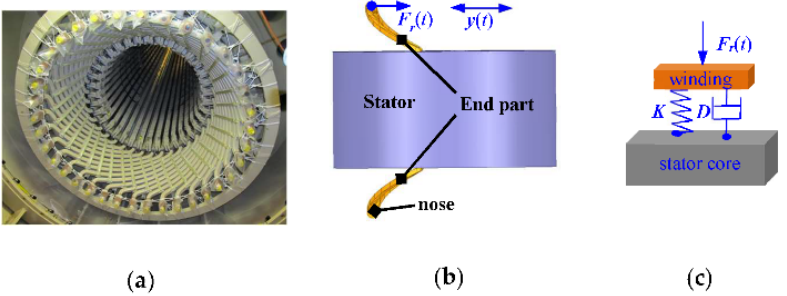
Figure 2. Stator core and winding: ( a ) real winding; ( b ) 3D models; and ( c ) mechanical